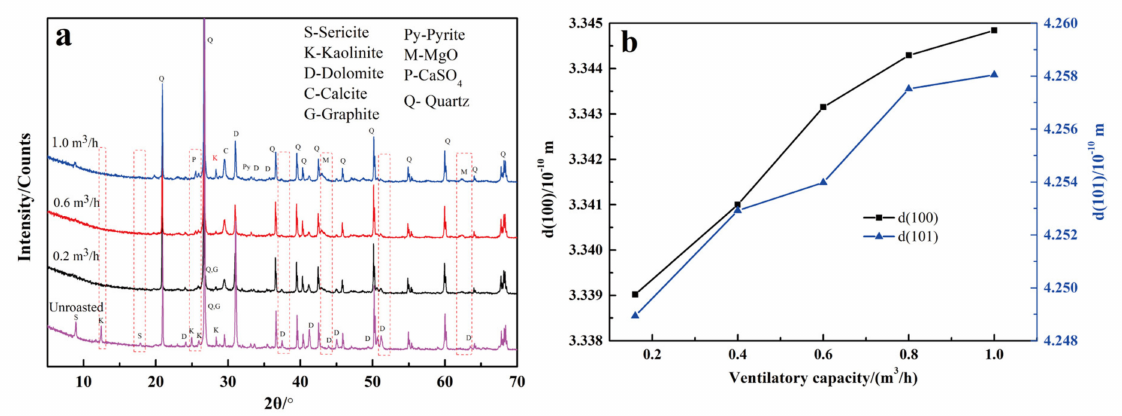
Figure 3. ( a ) XRD patterns of samples roasted at different ventilations and ( b ) effect of ventilation on quartz d100 and